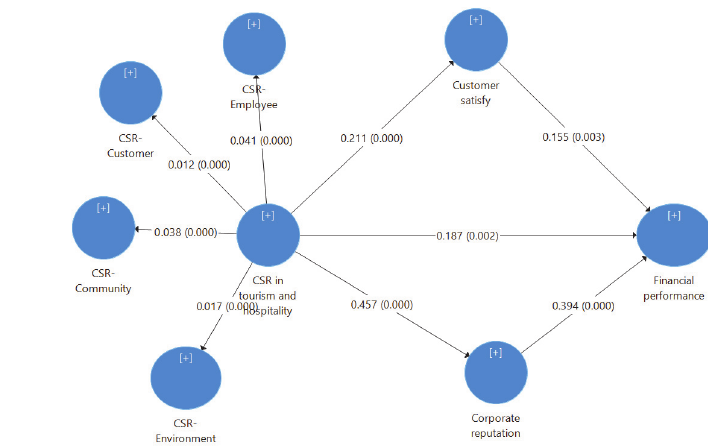
Fig. 2. Hypothesis test results (Bootstrap